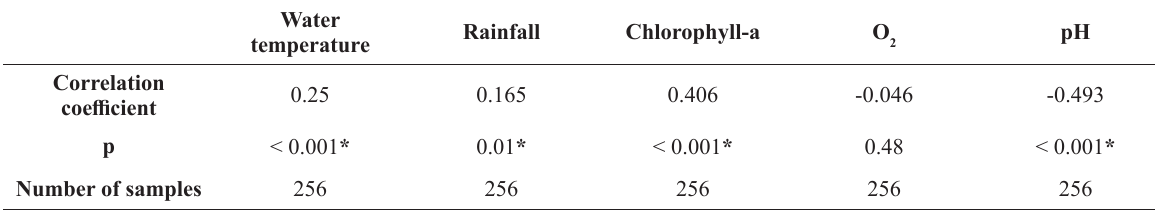
Test results of Spearman correlations between the adjusted mean fecundity values of Macrobrachium amazonicum (Heller, 1862) and the studied environmental factors in Tietê River, State of São Paulo,